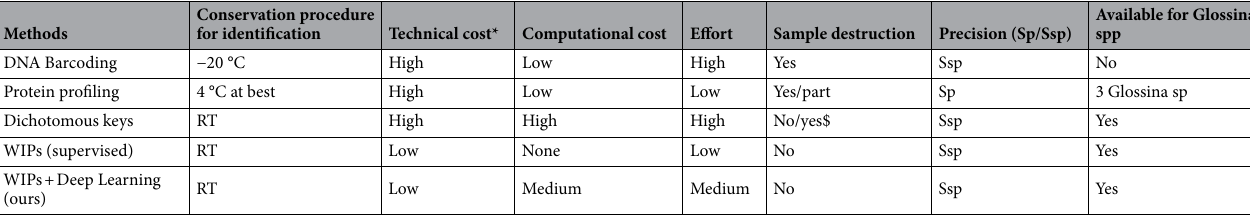
Table 5. Synthetic view of advantages and limitations of some identification methodologies for medically important arthropods. *The technical cost includes sample preparation (DNA, protein extraction, slides, etc.) and expenses linked to the need for a skilled professional. $ Samples destruction can be necessary for some species of medically important insects like Psychodidae, sp species, Ssp